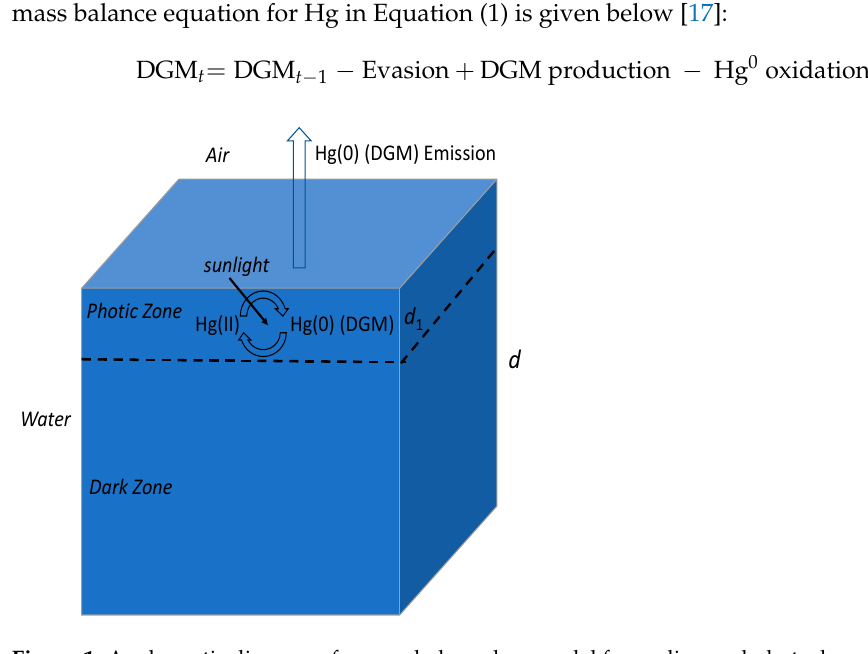
Figure 1. A schematic diagram of a mass balance box model for cycling and photochemodynamics of Hg in aquatic systems (after [17]).